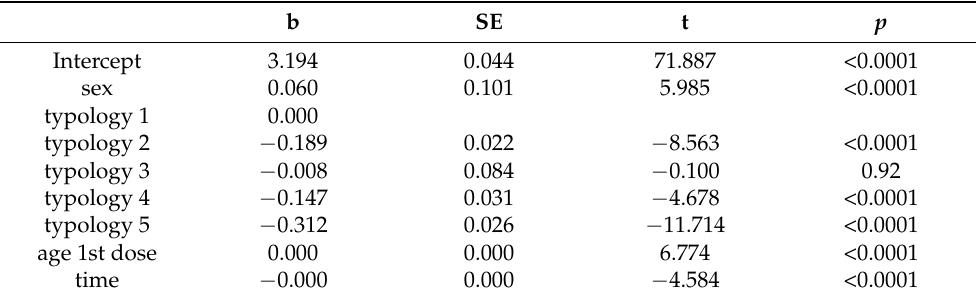
Table 4. Multiple linear regression among the logarithmic transformation of antibody titer of measles in vaccinated students and the independent variables sex, age of vaccination (or first dose of vaccine), time between vaccination, and antibody measurement and typology of vaccination (see legend). Statistically significant results are in